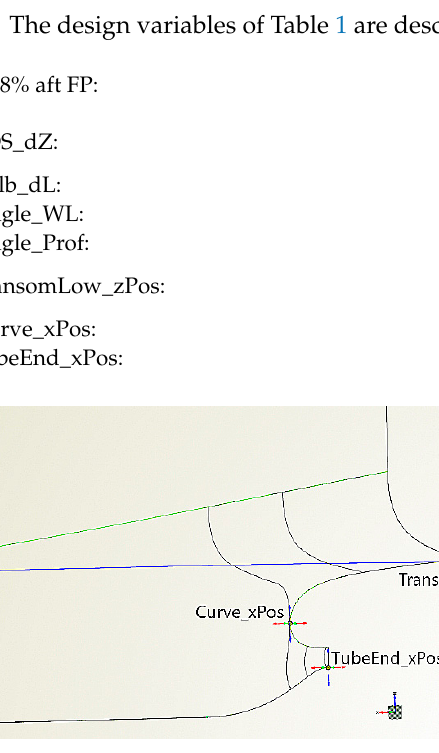
Figure 4. The three parameters set at the stern region.